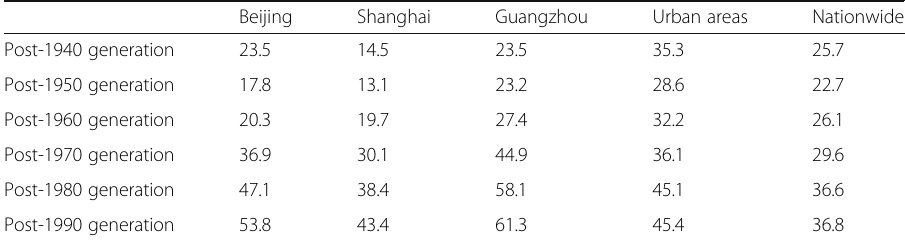
Table 1 Proportion of people classified as migrants across generations (%) Beijing Shanghai Guangzhou Urban areas